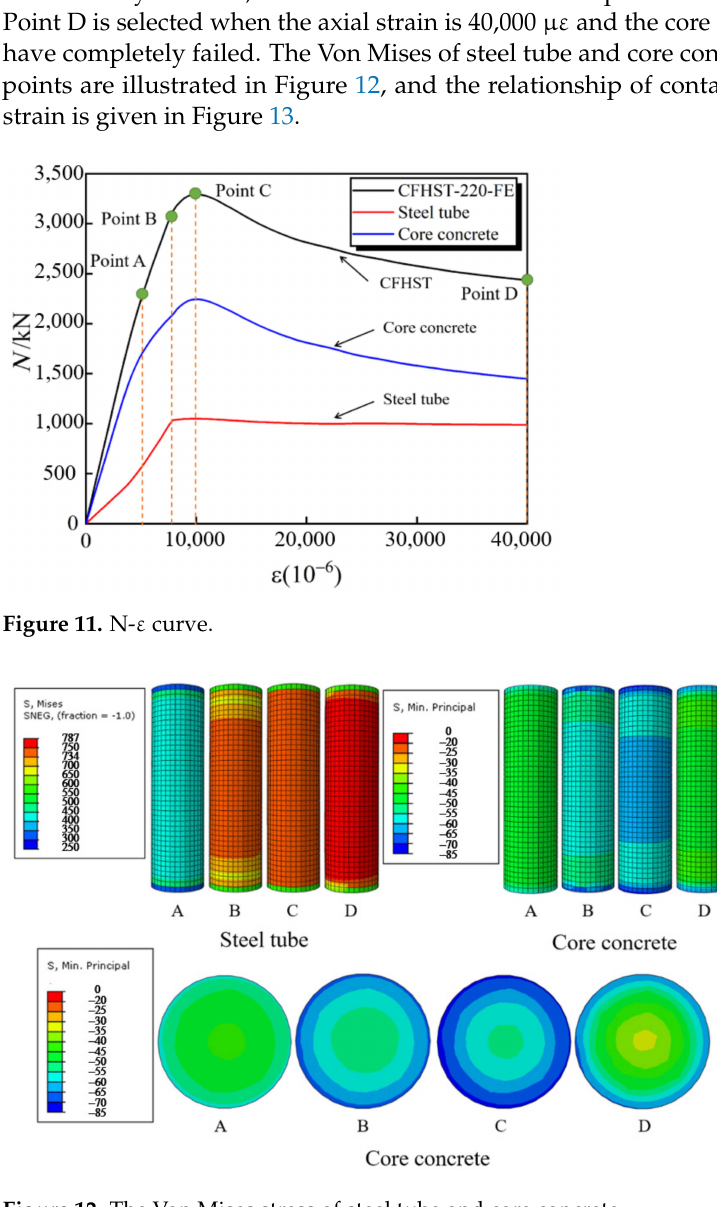
Figure 12. The Von Mises stress of steel tube and core